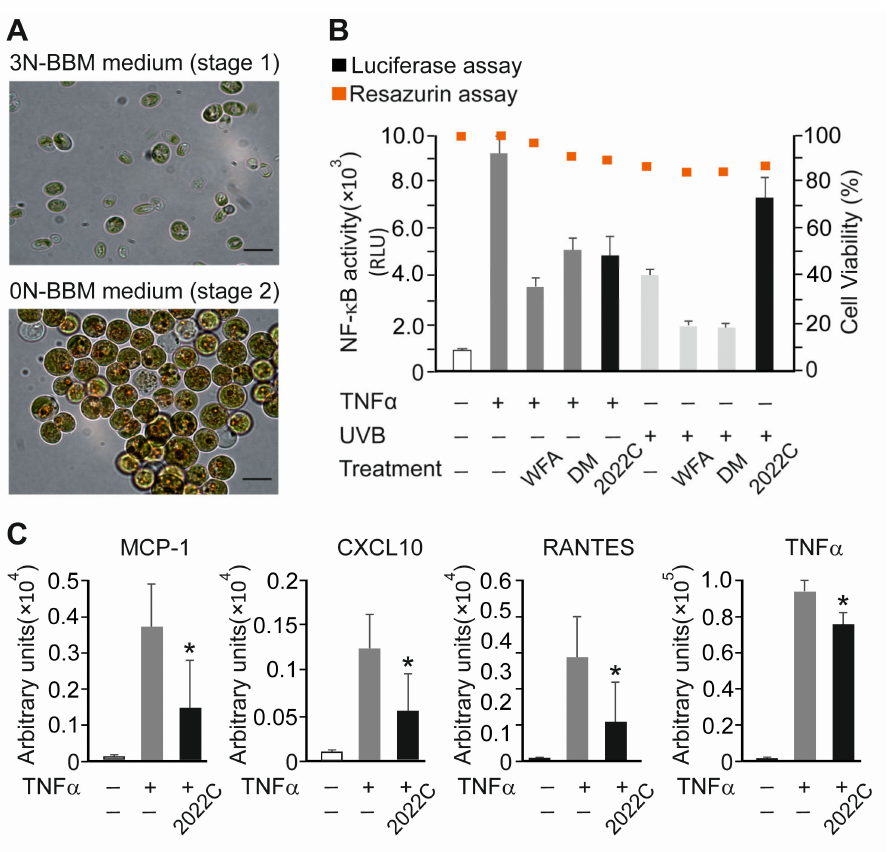
Figure 2. Inhibitory effects of NAE_2022C on TNF α - and UVB-induced inflammatory responses. ( A ) Brightfield micrographs of C. zofingiensis cultivated at standard growth conditions (stage 1; Upper) and after nitrogen deprivation stress (stage 2; Lower). Scale bar, 10 µ m. ( B ) NAE_2022C inhibited TNF α - but not UVB-induced NF- κ B responses. HaCaT cells were incubated with 100 nM DM, 750 nM WFA or 10 µ g mL − 1 NAE_2022C for 1 h and subsequently stimulated with 0.75 ng mL − 1 TNF α or irradiated with 0.15 J/cm 2 UVB. The luciferase activity was measured in cell lysates 6 or 24 h post-stimulation, respectively (left y-axis). The cell viability was evaluated using a resazurin assay and shown as orange squares (right y-axis). Data are presented as mean ± SD ( n = 3). ( C ) The suppression of TNF α -induced pro-inflammatory mediators in reconstituted human epidermis (epiCS) by NAE_2022C. The release of cytokines and chemokines was determined in the medium after the treatment of epiCS with 0.75 ng mL − 1 TNF α for 24 h (MCP1, RANTES and TNF α ) and 48 h (CXCL10) using the Luminex Assay. Data represent the mean ± SD of at least three independent biological replicates. * p < 0.05 vs. samples treated with DMSO and TNF α